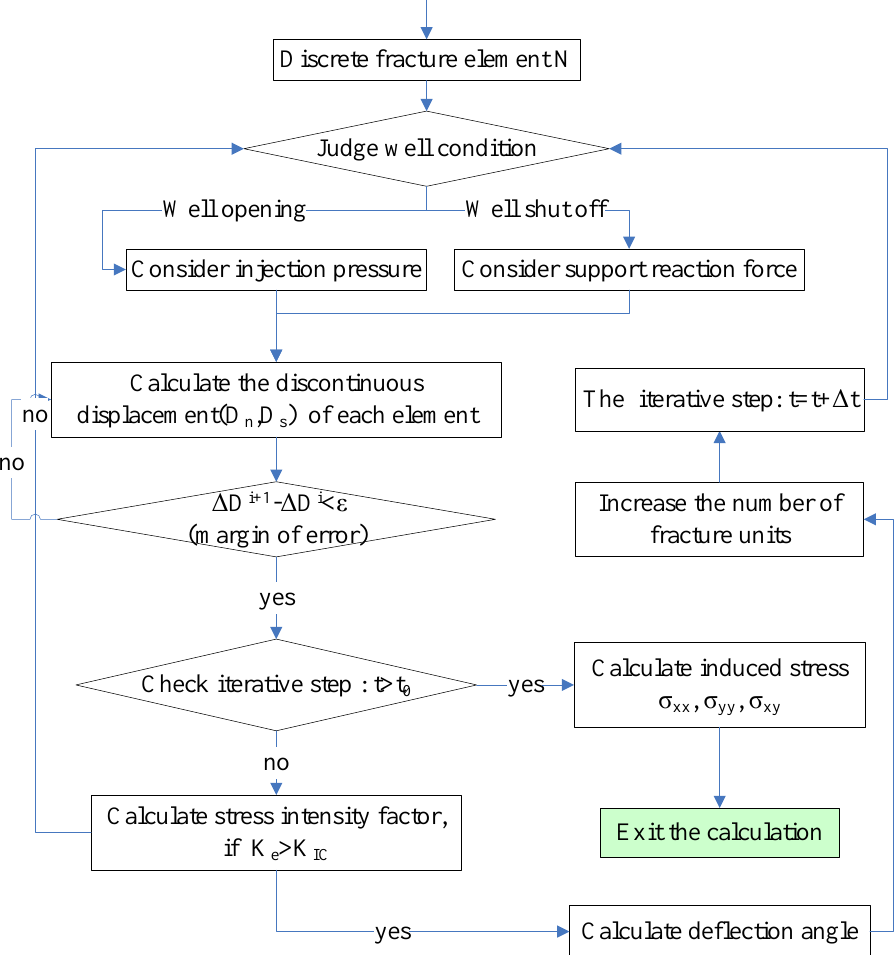
Figure 1. Computer program flow chart.